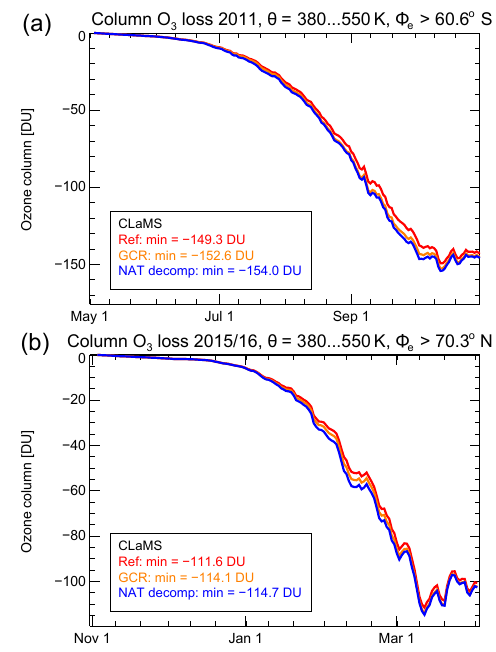
Figure 15. Simulated column ozone loss between 380 and 550K potential temperature for the Antarctic winter 2011 (a) and the Arc- tic winter 2015/2016 (b) . The results are shown for different sensi- tivity simulations. Red lines correspond to the reference simulation, orange lines to the simulation including GCR-induced ionisation, and blue lines to the NAT decomp simulation. The legend also indi- cates the maximum column ozone loss amount of each